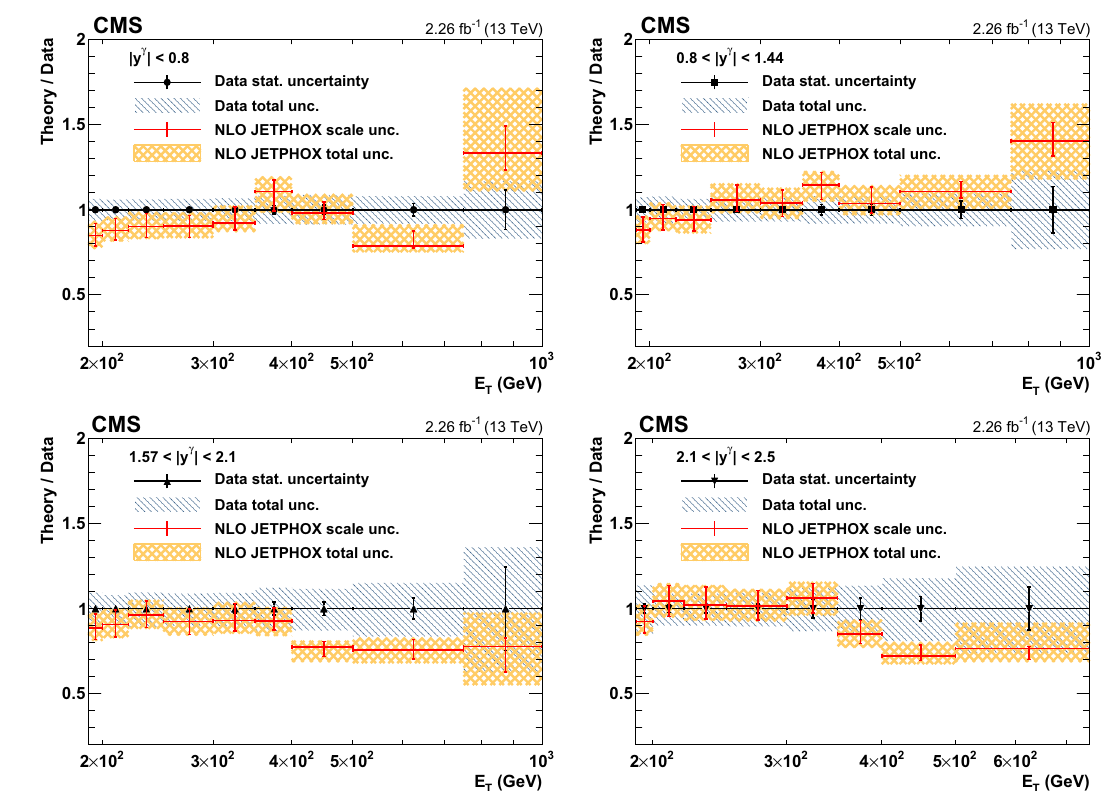
Fig. 4 The ratios of theoretical NLO predictions to data for the dif- ferential cross sections for isolated-photon production in four photon rapidity bins, | y γ | < 0 . 8, 0 . 8 < | y γ | < 1 . 44, 1 . 57 < | y γ | < 2 . 1, and 2 . 1 < | y γ | < 2 . 5, are shown. The error bars on data points represent The distributions of the BDT values are used in a